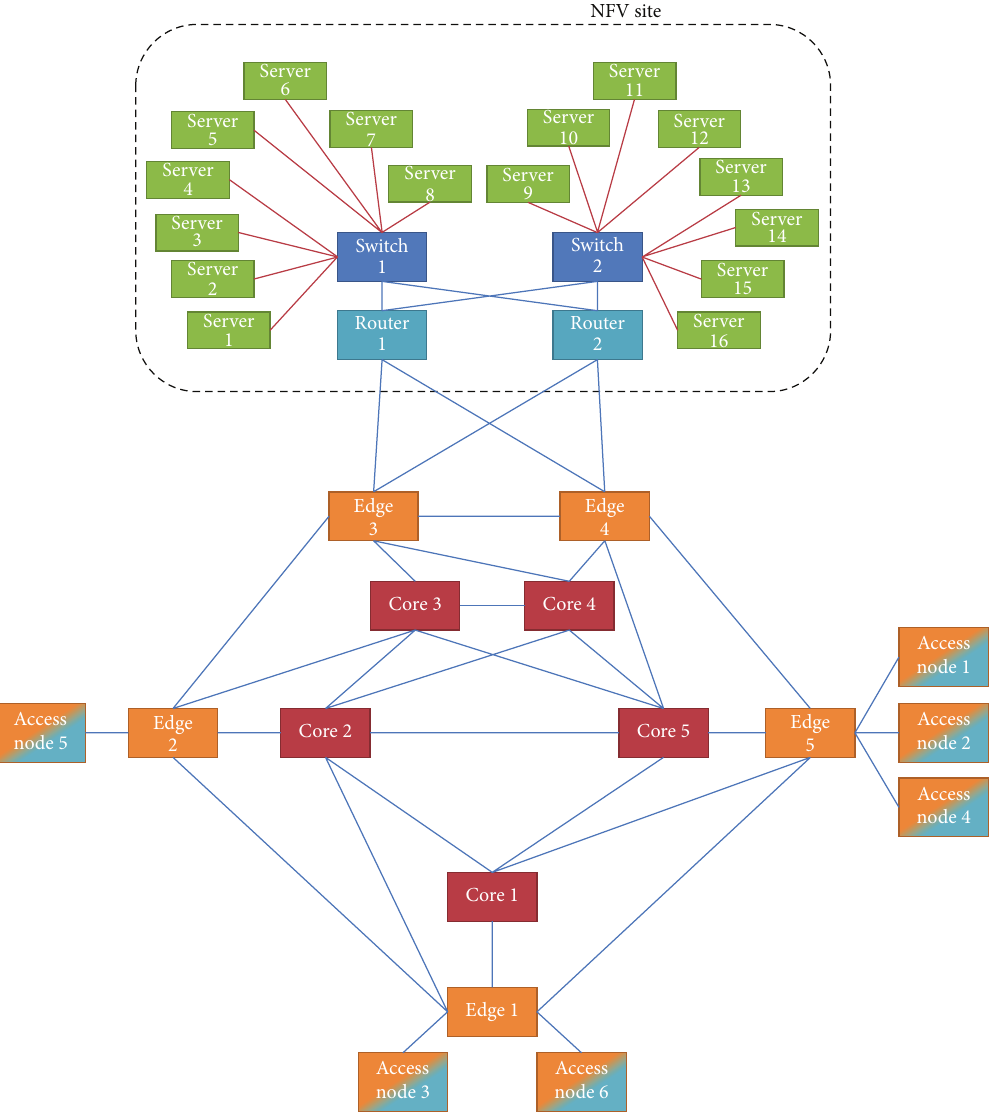
Figure 5: The network topology is composed of six access nodes, five edge nodes, and five core nodes. The NFV site is composed of two routers, two switches, and sixteen